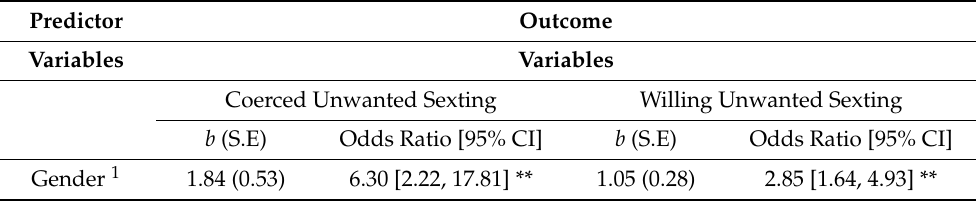
Table 2. Associations between sexting coercion variables and